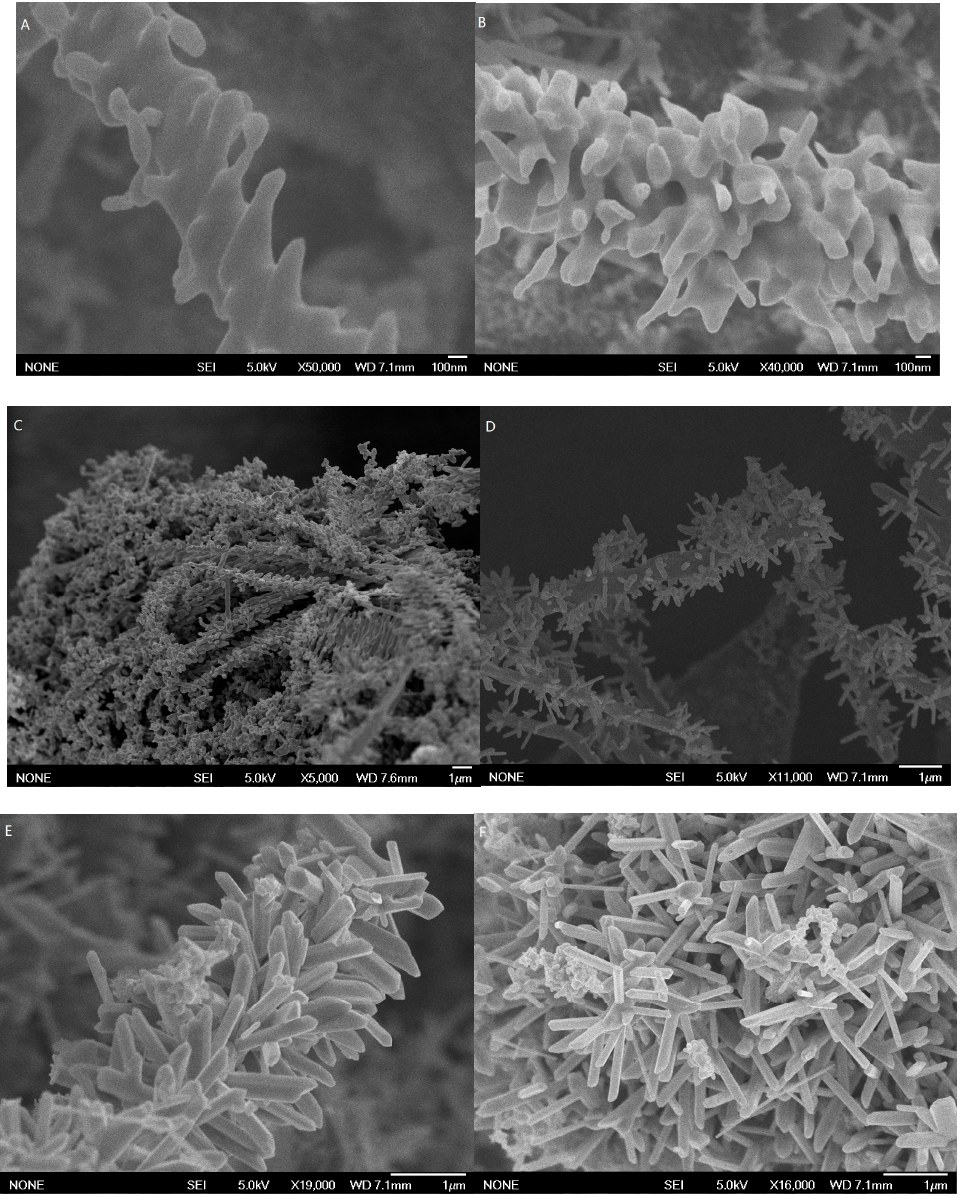
Figure 1. Typical SEM images of the branch-trunk Ag hierarchical nanostructures of different reaction time. ( A,B ) 30 s ; ( C,D ) 60 s; ( E,F ) 90 s.